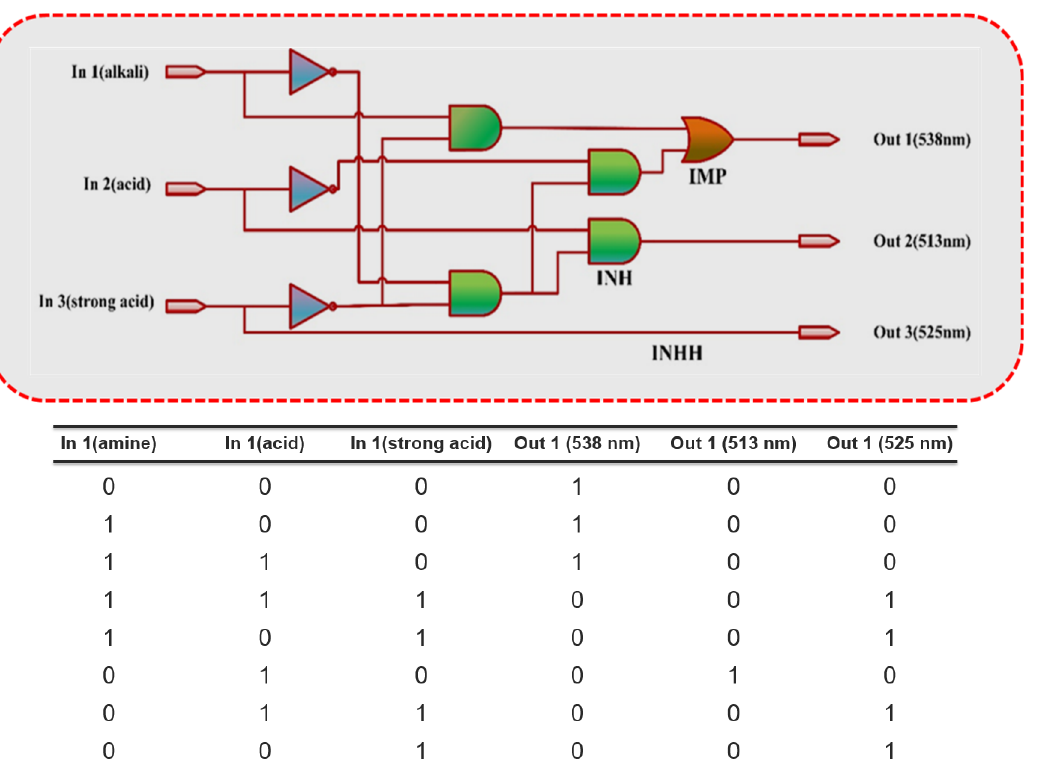
Figure 12. Images of PIP , NIP , TIP, and FIP (size: 1 cm × 1 cm) before and after fuming with TFA vapor under daylight ( upper ) and illumination with 365 nm UV light ( lower ).